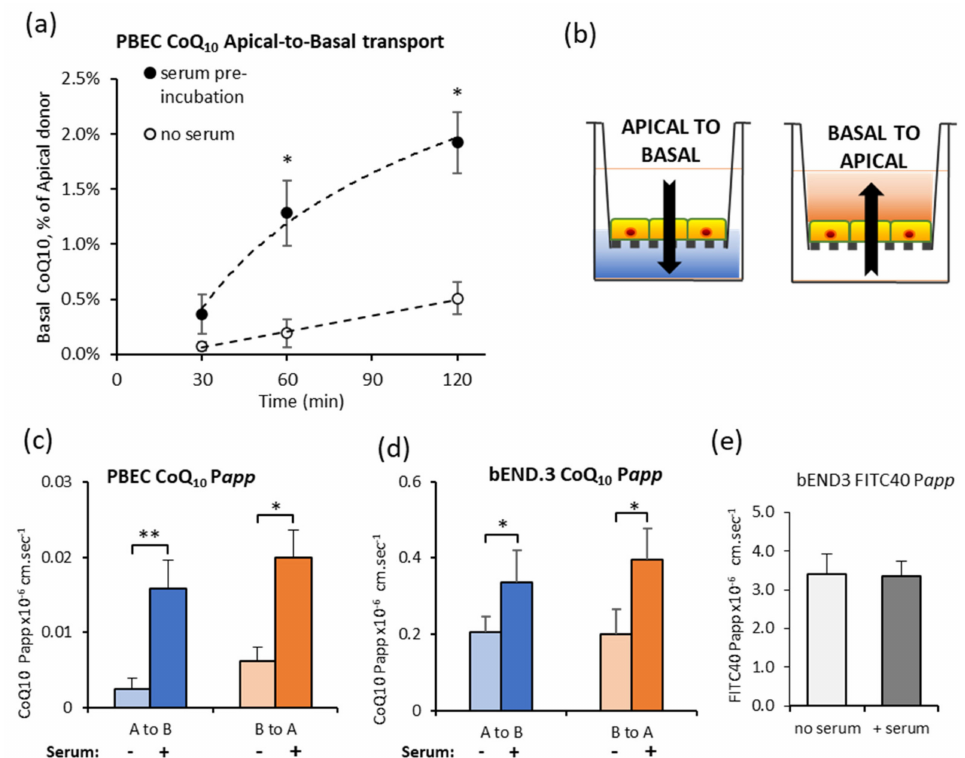
Figure 1. E ff ect of pre-incubating CoQ 10 in serum, on transport across the blood–brain barrier (BBB) in vitro models. ( a ) CoQ 10 transport across porcine brain endothelial cells (PBEC) monolayer is increased by pre-incubation of CoQ 10 in serum. CoQ 10 was either pre-incubated for 45 min in serum, or added directly to apical assay bu ff er (no serum), and appearance in the basal bu ff er measured after 30, 60 or 120 min; n = 4–7. ( b ) Schematic of transport assays using BBB cells grown on Transwell filters. CoQ 10 and FITC-40 can be added to the apical compartment to measure transport from blood-to-brain, (apical to basal), or to the basal compartment to measure brain-to-blood transport (basal to apical). CoQ 10 P app across PBEC ( c ) and bEnd.3 ( d ) monolayers after 60 min. Transport in both directions, blood-to-brain side (A to B) and brain-to-blood side (B to A) was increased after pre-incubation of CoQ 10 in serum; n = 4–10. ( e ) FITC-40 P app across b.End3 monolayer over 60 min. Pre-incubation of FITC-40 in serum did not change transport in either direction; n = 6–12. Values are mean ± SEM; * p < 0.05, ** p <